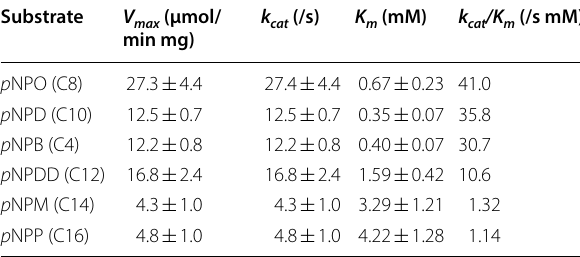
Table 1 The kinetic values of purified recombinant Tl LipA towards esters of different lengths